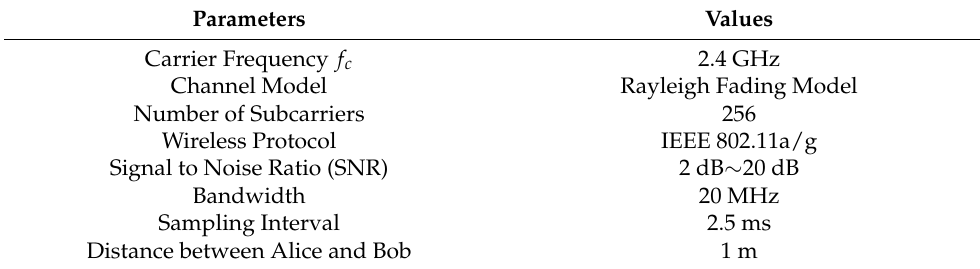
Table 2. The parameter